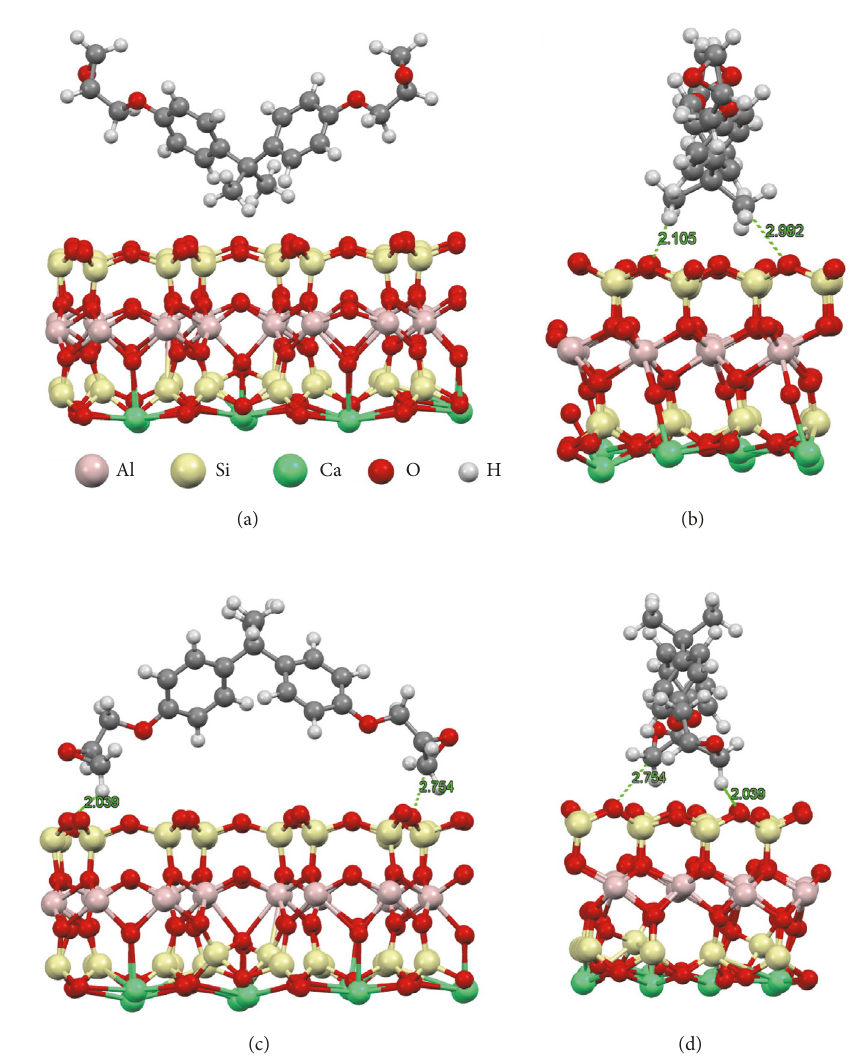
Figure 3: Different situations epoxy monomer approached the surface of MMT and the equilibrium distances between the closest atom of the epoxy and the layer of